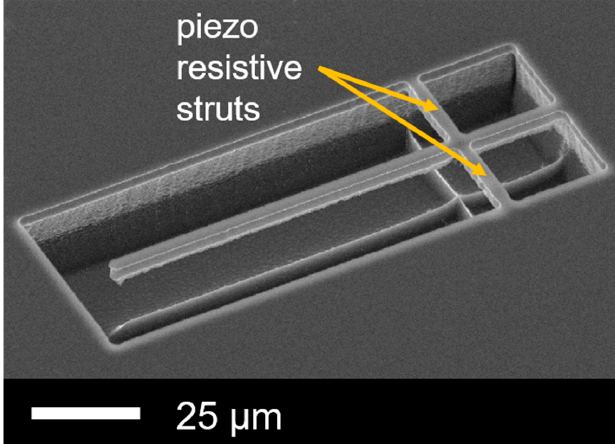
Sensors 2019 , 19 , x FOR PEER REVIEW Figure 1. Etched Si micro cantilever with piezo-resistive struts. Figure 1. Etched Si micro cantilever with piezo-resistive struts.